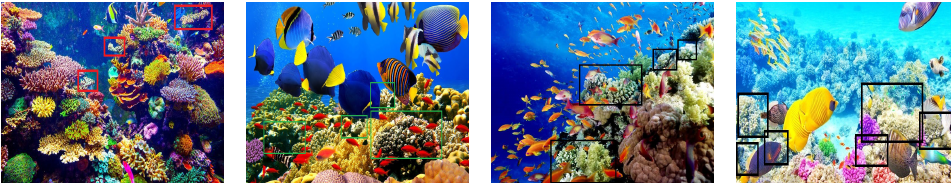
Figure 12. Positioning of the bleached corals in the full coral reef